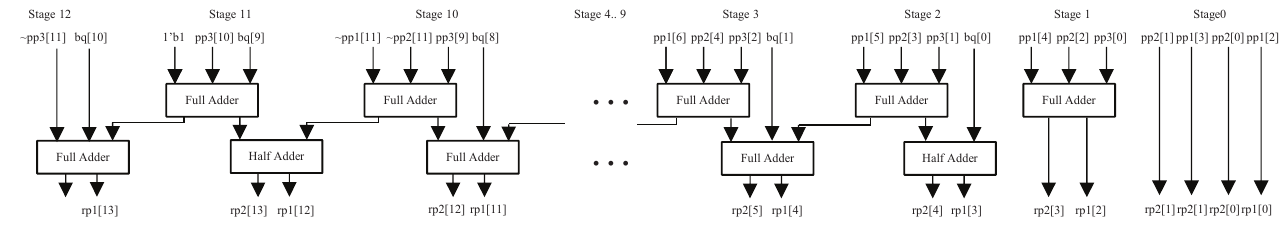
and 1 √ . The symbols rp1 and 1 + f 1 + f